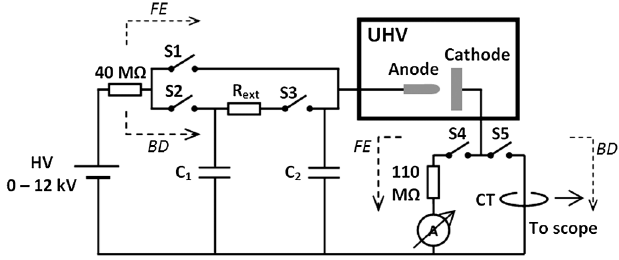
FIG. 1. Schematic drawing of the experimental setup. During field emission measurements (path labeled with ‘‘FE’’), the switches S1 and S4 are closed. During breakdown field mea- surements (path labeled with ‘‘BD’’), first S2 is closed to charge C 1 , then switches S3 and S5 are closed, while all other switches are open; thus, the circuit consists of C 1 storing the energy, ¼ 25 (cid:1) limiting the overshoot voltage (and as a conse- R ext quence, limiting the current during breakdown as well), the overshoot capacitor C 2 , and the discharge gap.